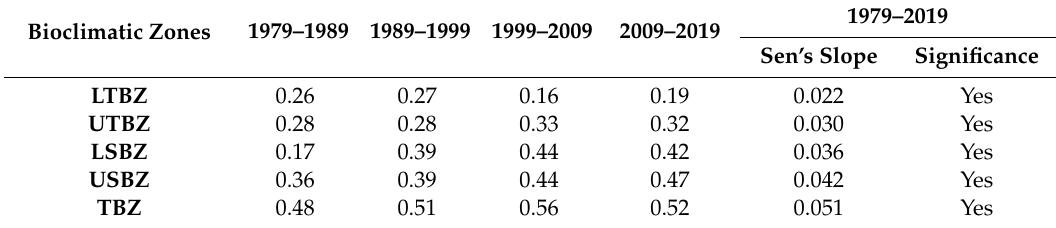
Table 4. Increased average temperature ( ◦ C) per decade in di ff erent bioclimatic zones of CHAL since